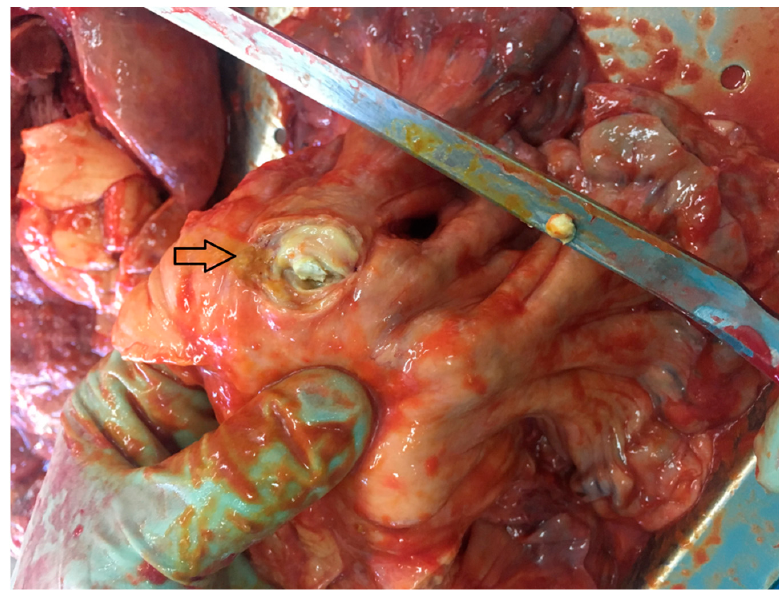
Figure 3. Tumor in the mesentery of the small intestine (indicated by the arrow).